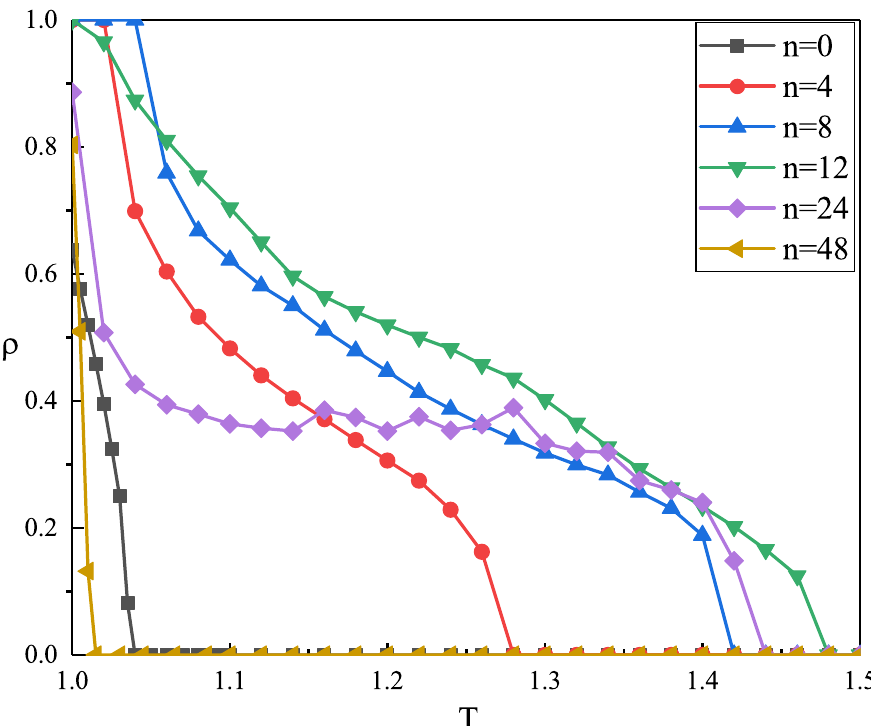
Figure 4. Fraction of cooperators at the stationary state as a function of T for different numbers of information acquisition n when the probability of information acquisition q is fixed to be 0.5. Different color curves denote the results under different n . Other model parameters are fixed as: L = 100, K = 0.1 and c =